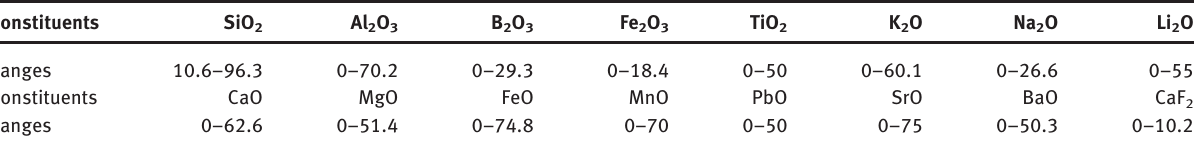
Table 2: Composition ranges of molten slags in the database (mol%). Constituents